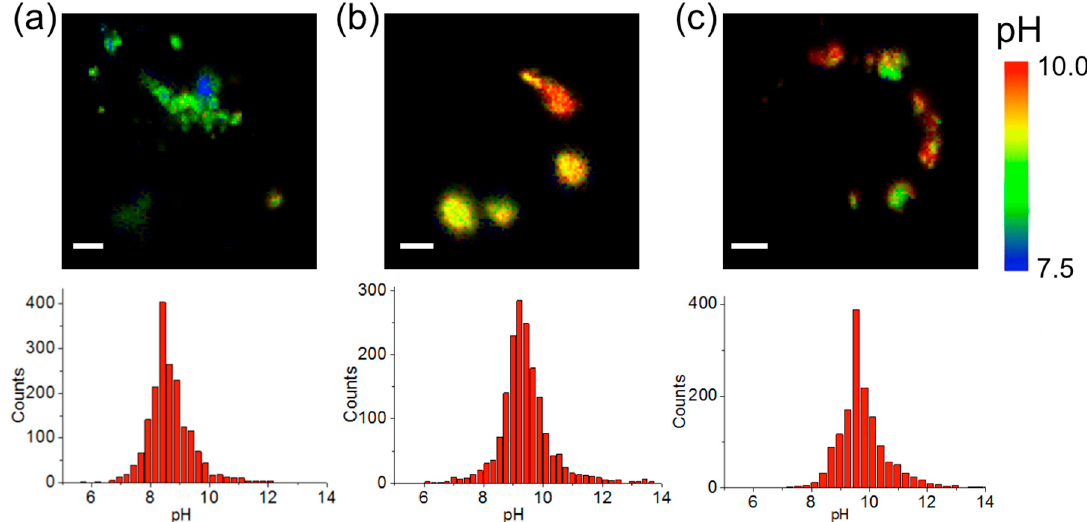
Figure 3. Representative pH m images and the corresponding pH m distributions obtained from the PL lifetime, τ , of QD-SS20-MPA nanosensors incorporated into the mitochondria of MCF7 ( a ), MDA-MB-231 ( b ), and MDA-MB-468 ( c ) breast cancer cells. Scale bars represent 10 µm.